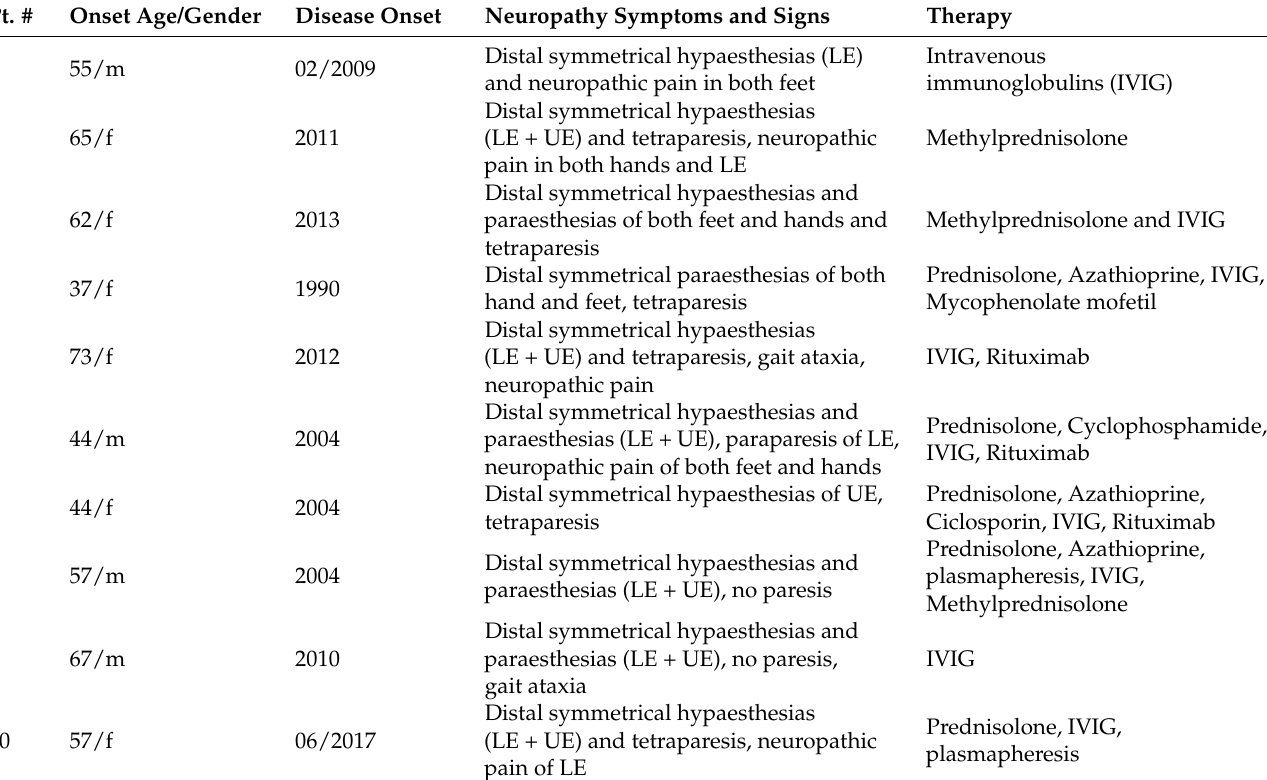
Table 2. Characteristics of patients with CIDP (chronic inflammatory demyelinating polyradiculoneuropathy). Pt.